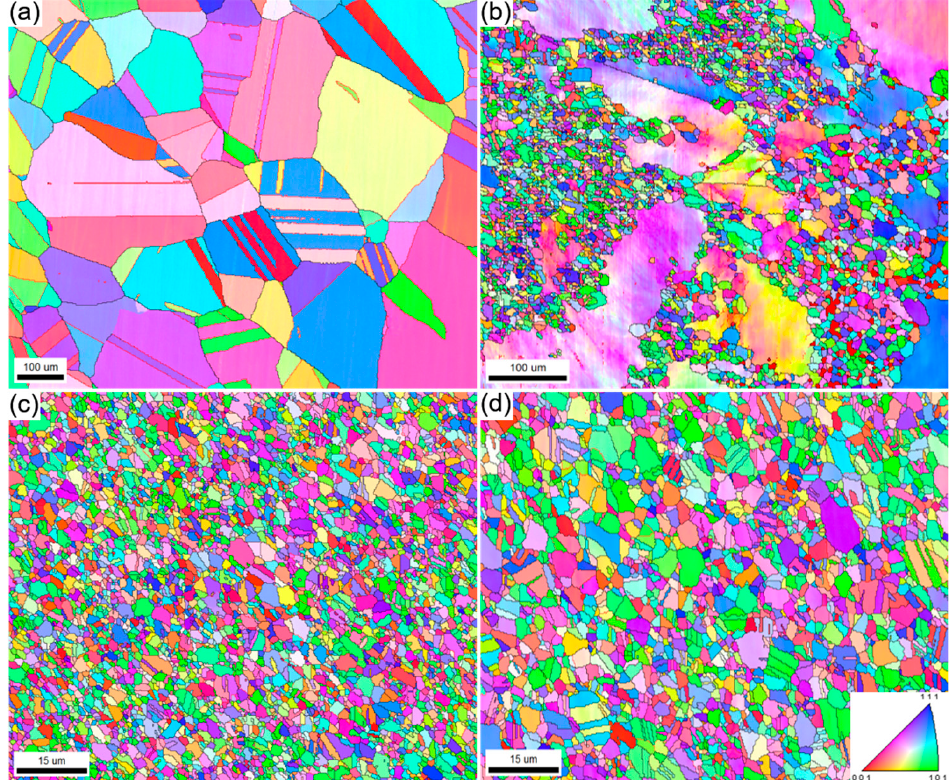
Figure 1. EBSD IPF images show the grain morphology of the ( a ) as-solutionized (AS), ( b ) hot-rolled (HR), ( c ) cold-rolled and heat-treated at 973 K for 30 min (HT1), ( d ) cold-rolled and heat-treated at 1023 K for 30 min (HT2) of the Co 35 Cr 25 Mn 15 Ni 15 Fe 10 HEA.